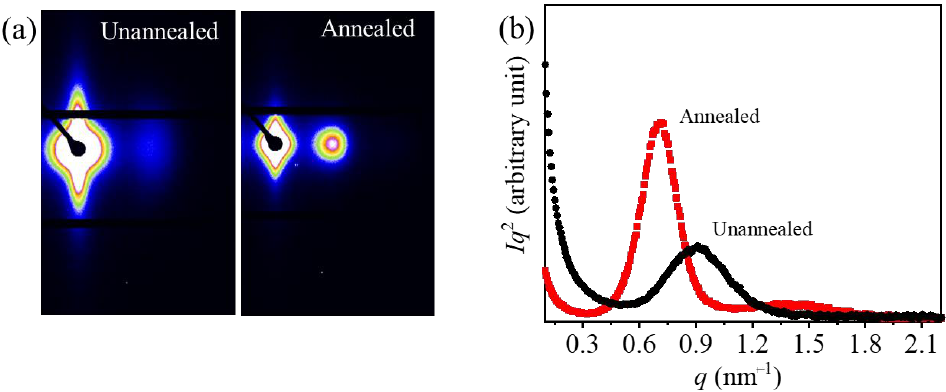
Figure 8. ( a ) SAXS patterns of unannealed and annealed films. The drawing direction is horizontal and is defined as the meridian. ( b ) Meridional lines of Lorentz-corrected 1D SAXS of unannealed and annealed samples.